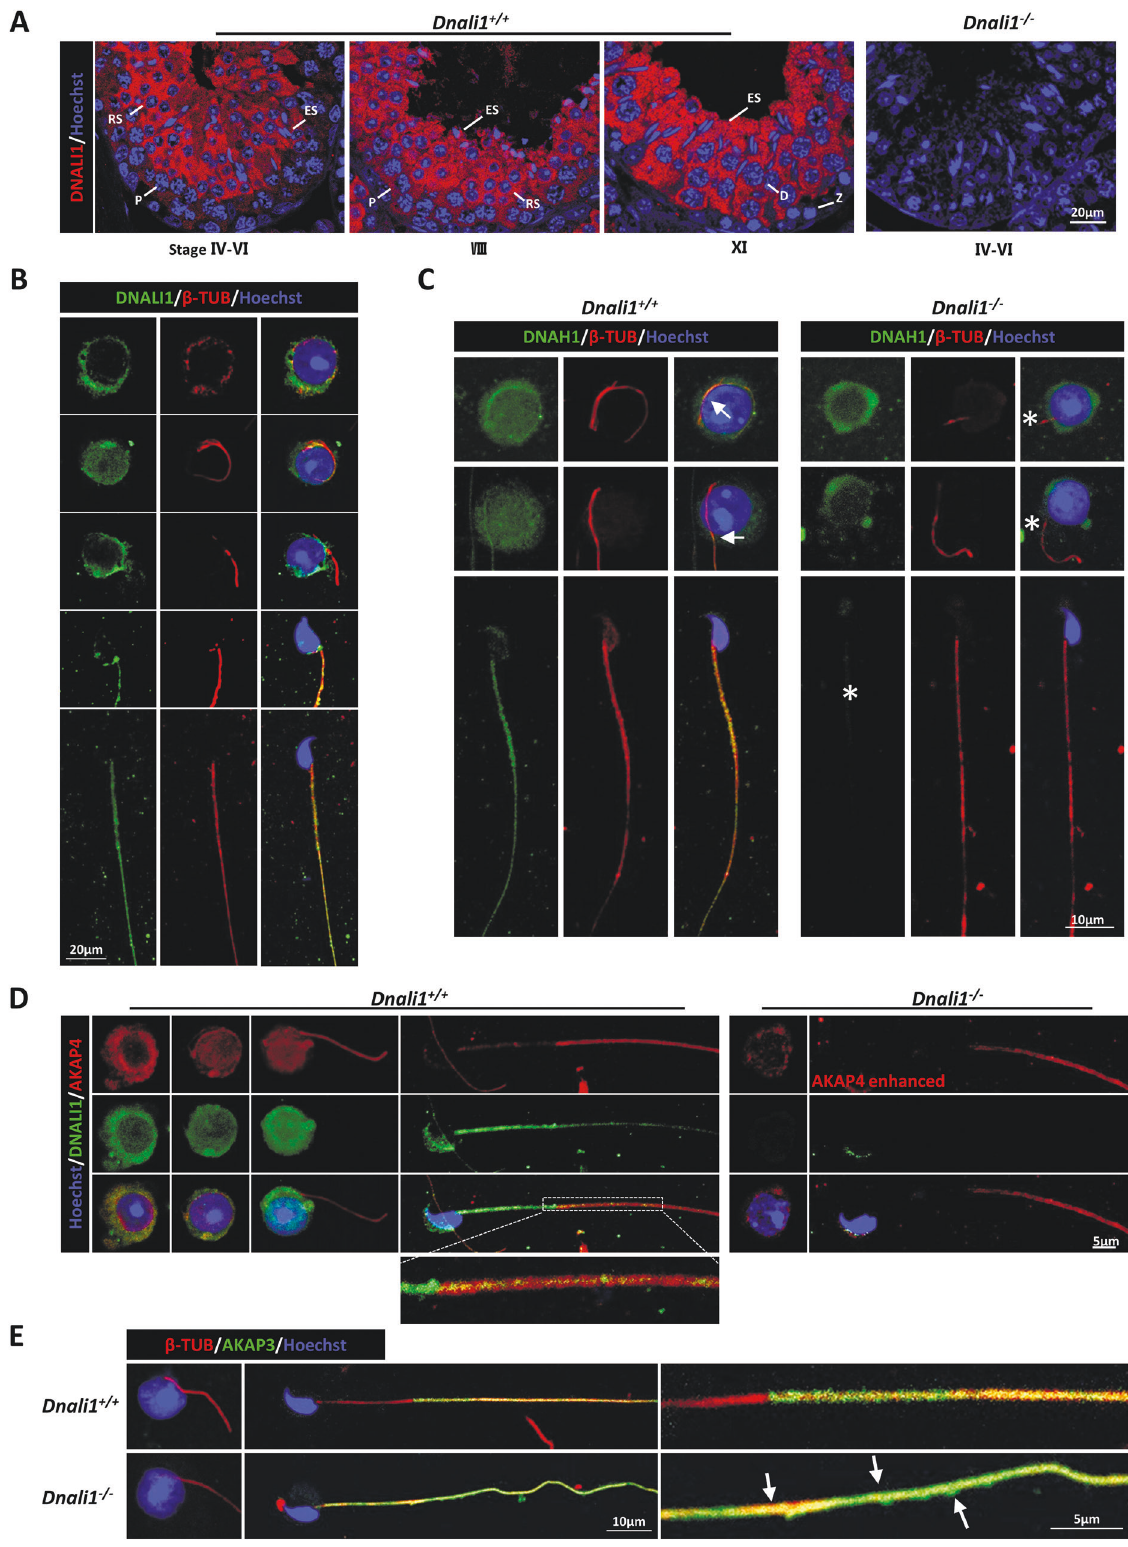
Fig. 5 DNALI1 localizes in the cytoplasm of spermatids and regulates the assembly of structural proteins in the fl agellum. A DNALI1 staining at distinct murine developmental phases of the male germ cells, as evidenced by IF. Z zygotene, P Pachytene, D Diplotene, RS round spermatid, ES elongated spermatids. B IF analysis of round and elongated spermatids from the Dnali1 + / + mice. C The expression and location of DNAH1 during spermiogenesis. The DNAH1 protein is expressed, but cannot be assembled into the fl agella. Arrows indicate the localization of DNAH1 in the fl agella, and the asterisks indicate the absence. D The AKAP4 staining during spermiogenesis. The AKAP4 expression and assembly ef fi ciency are signi fi cantly reduced. E IF analysis of AKAP3 during spermiogenesis. Arrows mark the abnormal distribution of AKAP3.